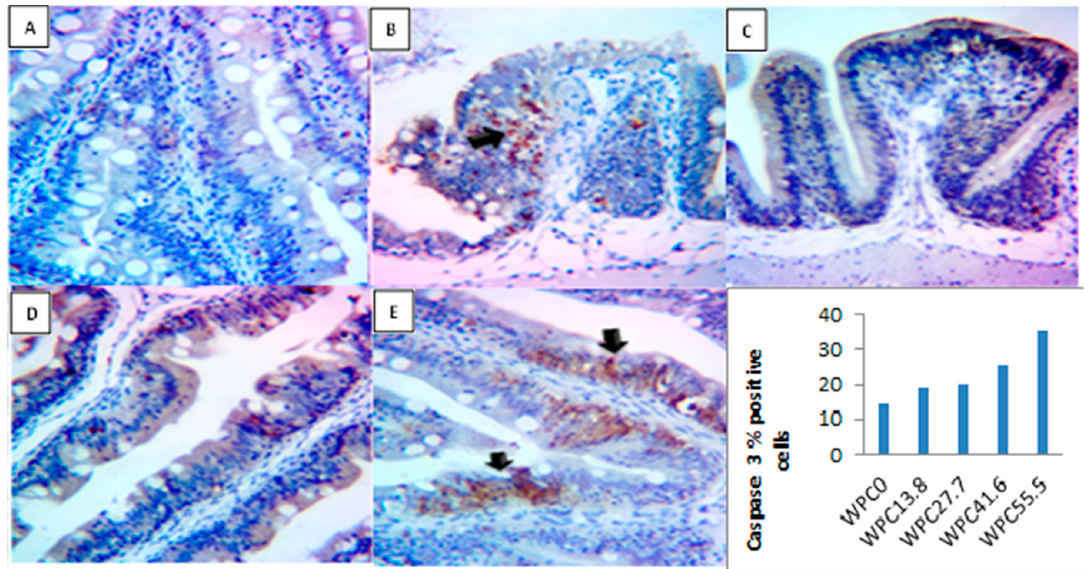
Figure 8. Representative photomicrograph of the Caspase 3 IHC stained sections and quantification analysis for area % of Caspase 3 immunopositive cells at magnification 400x from the fish intestine before bacterial challenge showing: ( A ) Limited brownish stained enterocytes in WPC0; ( B , C ) slight brown stained deposits in the numerous enterocytes in both WPC13.8 and WPC27.7; ( D ) marked stained enterocytes and numerous cells in lamina propria (arrow) in WPC41.6; ( E ) marked to intense brownish stained enterocytes especially in the basal villi (arrows) in WPC55.5.